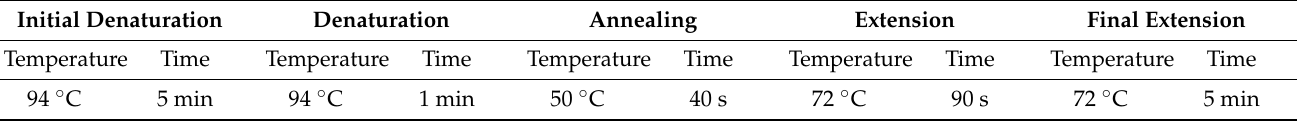
Table 2. PCR condition for 16s RNA universal